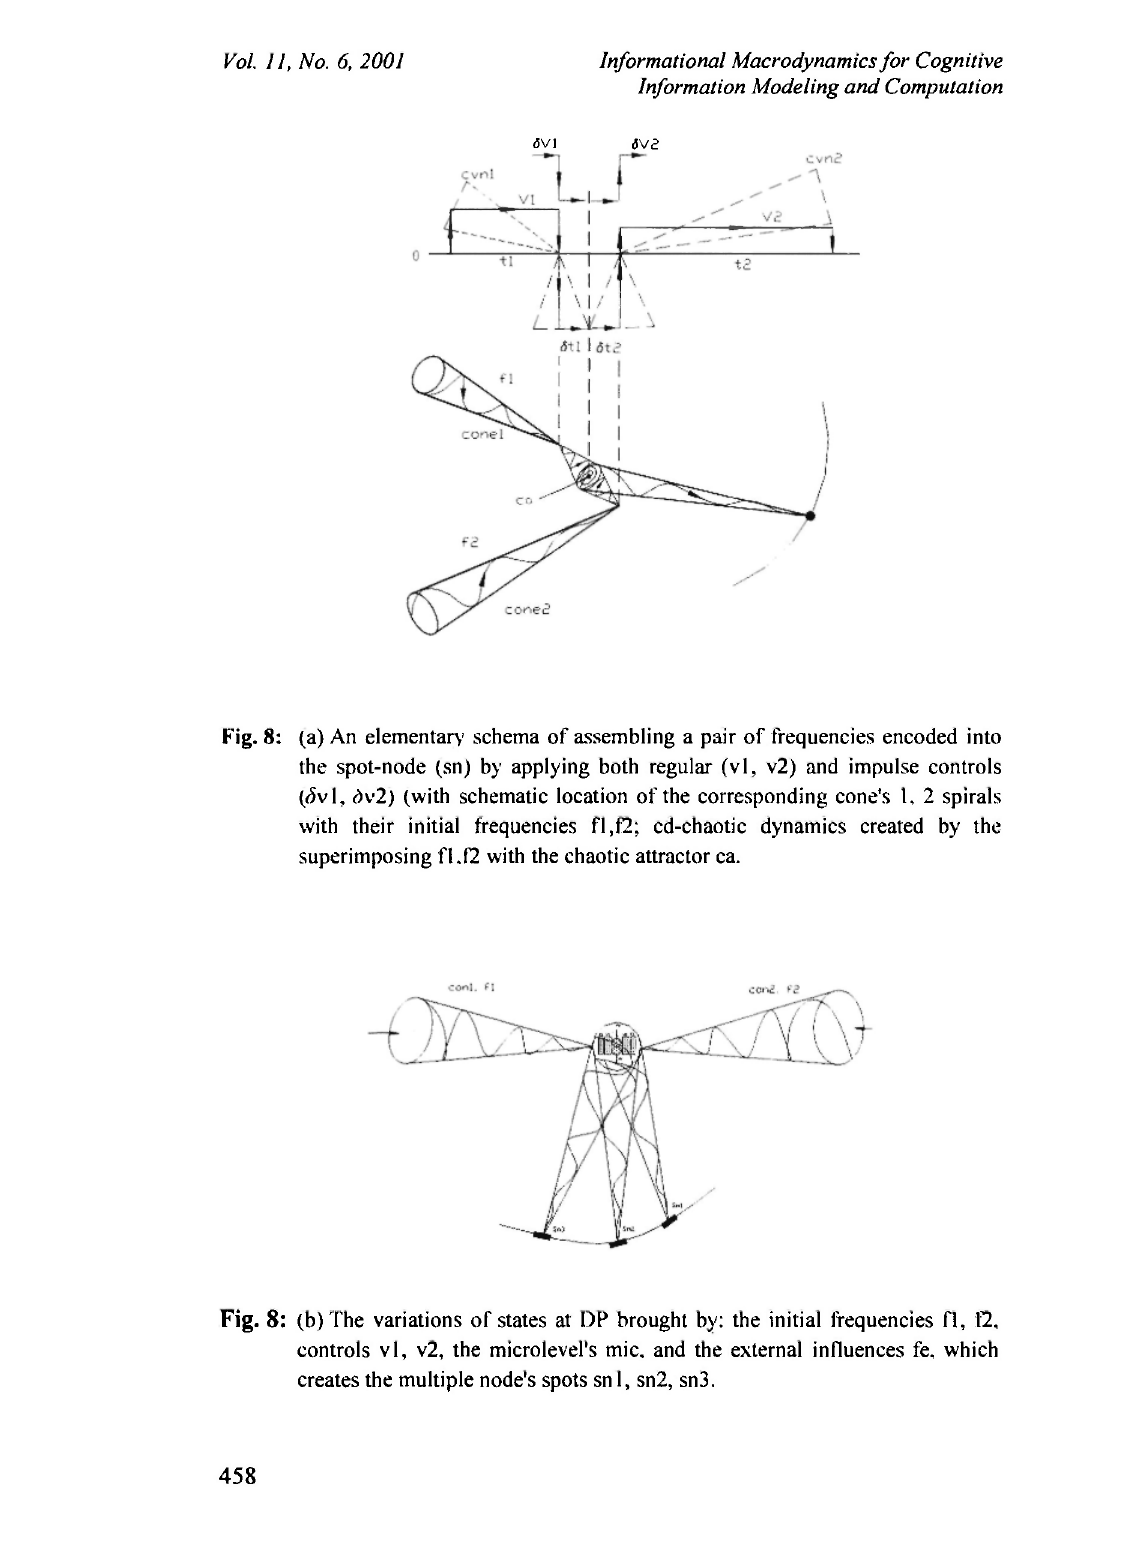
Fig. 8: (b)The variations of states at DP brought by: the initial frequencies ft, 12. controls vl, v2, the microlevel's mic. and the external influences fe, which creates the multiple node's spots snl, sn2,